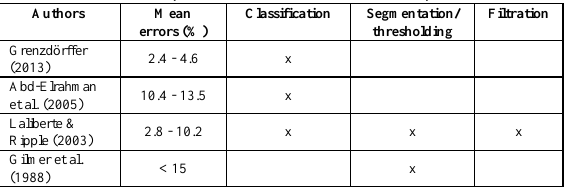
Table 1: Mean errors obtained by four authors for automatic counts procedures and used techniques. Authors